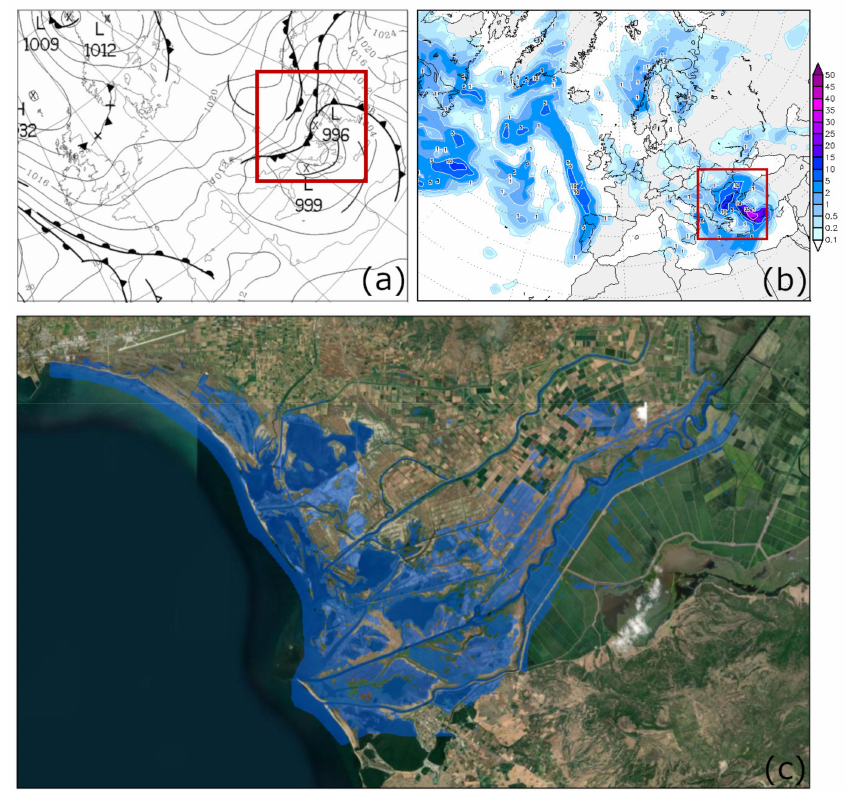
Figure A3. As in Figure A1, but for the 2010 flood